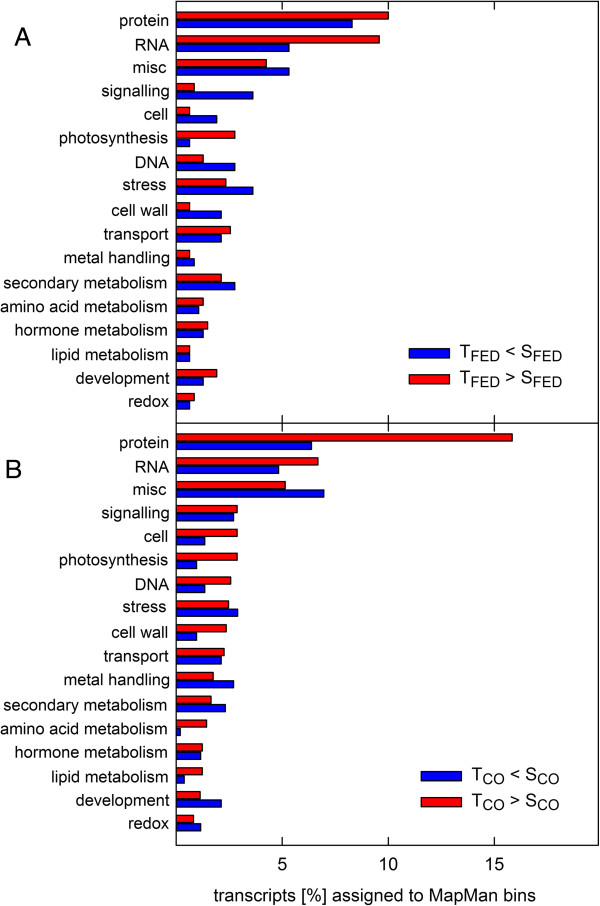
Functional composition of the different candidate transcript groups. Transcripts from the TFED > SFED- (red) and TFED < SFED- (blue) groups (A) and TCO > SCO- (red) and TCO < SCO- (blue) groups (B) were assigned to MapMan BINs and transcripts per BIN were counted (counts in% of total transcript counts in the candidate group on the X-axes). Only MapMan BINs showing at least 3 members in all groups were displayed. Unassigned transcripts were not displayed. CO, control sample; FED, fed sample.